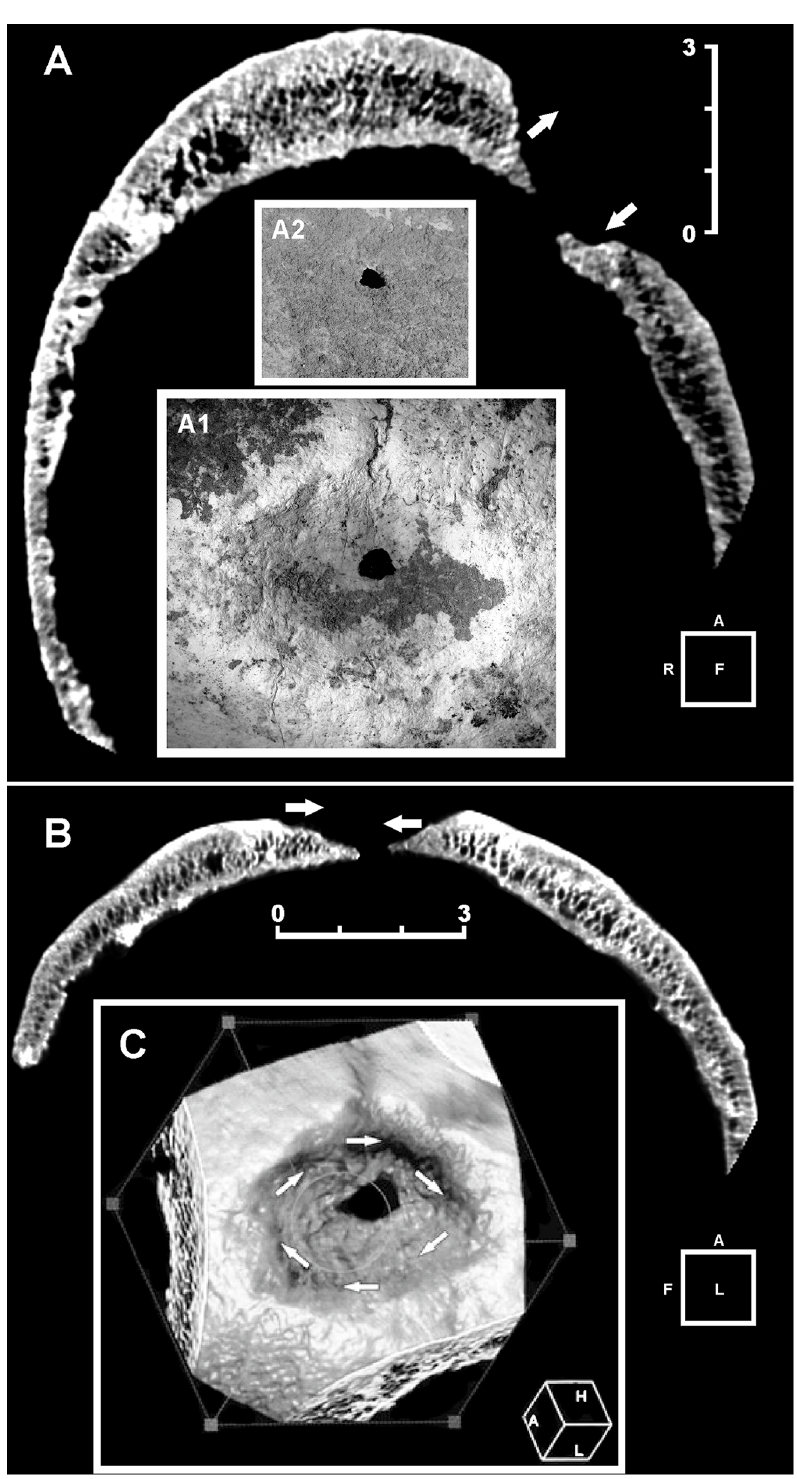
Fig 3. Three-dimensional (3D) computed tomography (CT) scan of the main skull trephination. Frontal (A) and sagittal (B) plane CT scan. Extensive and irregular bone reconstruction is apparent. No evidence is seen of incomplete healing processes as in the case of complication by infection. Note the different angle at the top/bottom (frontal plane) (A) and front/back (sagittal plane) (B) bone around the hole, indicative of right- handed clockwise rotation applied during the action of scraping (arrows). Detail of the main lesion,